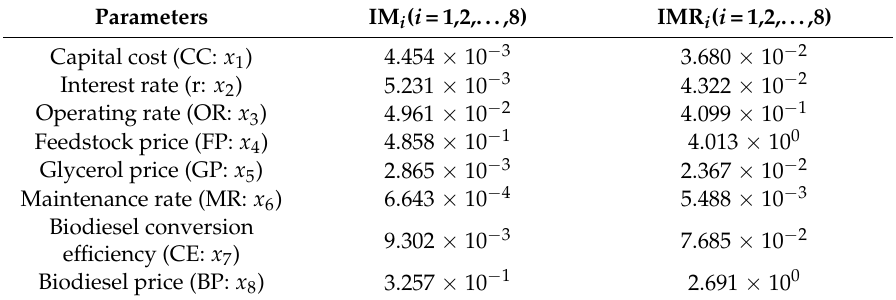
Table 2. Results of the proposed sensitivity analysis IM i ( i = 1,2, . . . ,8 ) and IMR i ( i = 1,2, . . . ,8 ) .